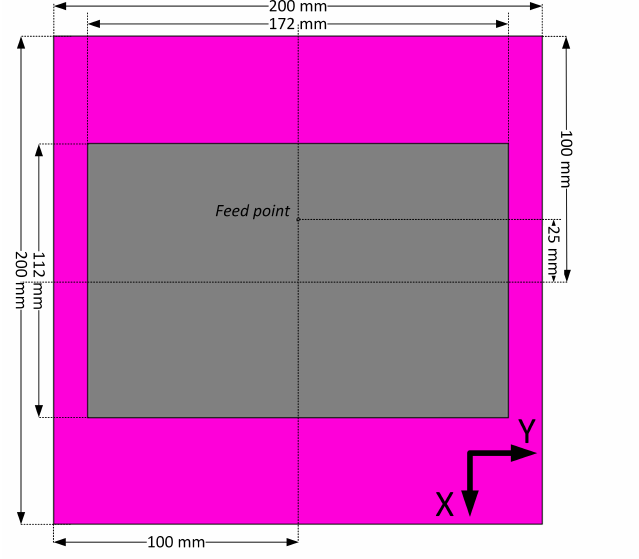
Figure 6. Layout and dimensions of the designed